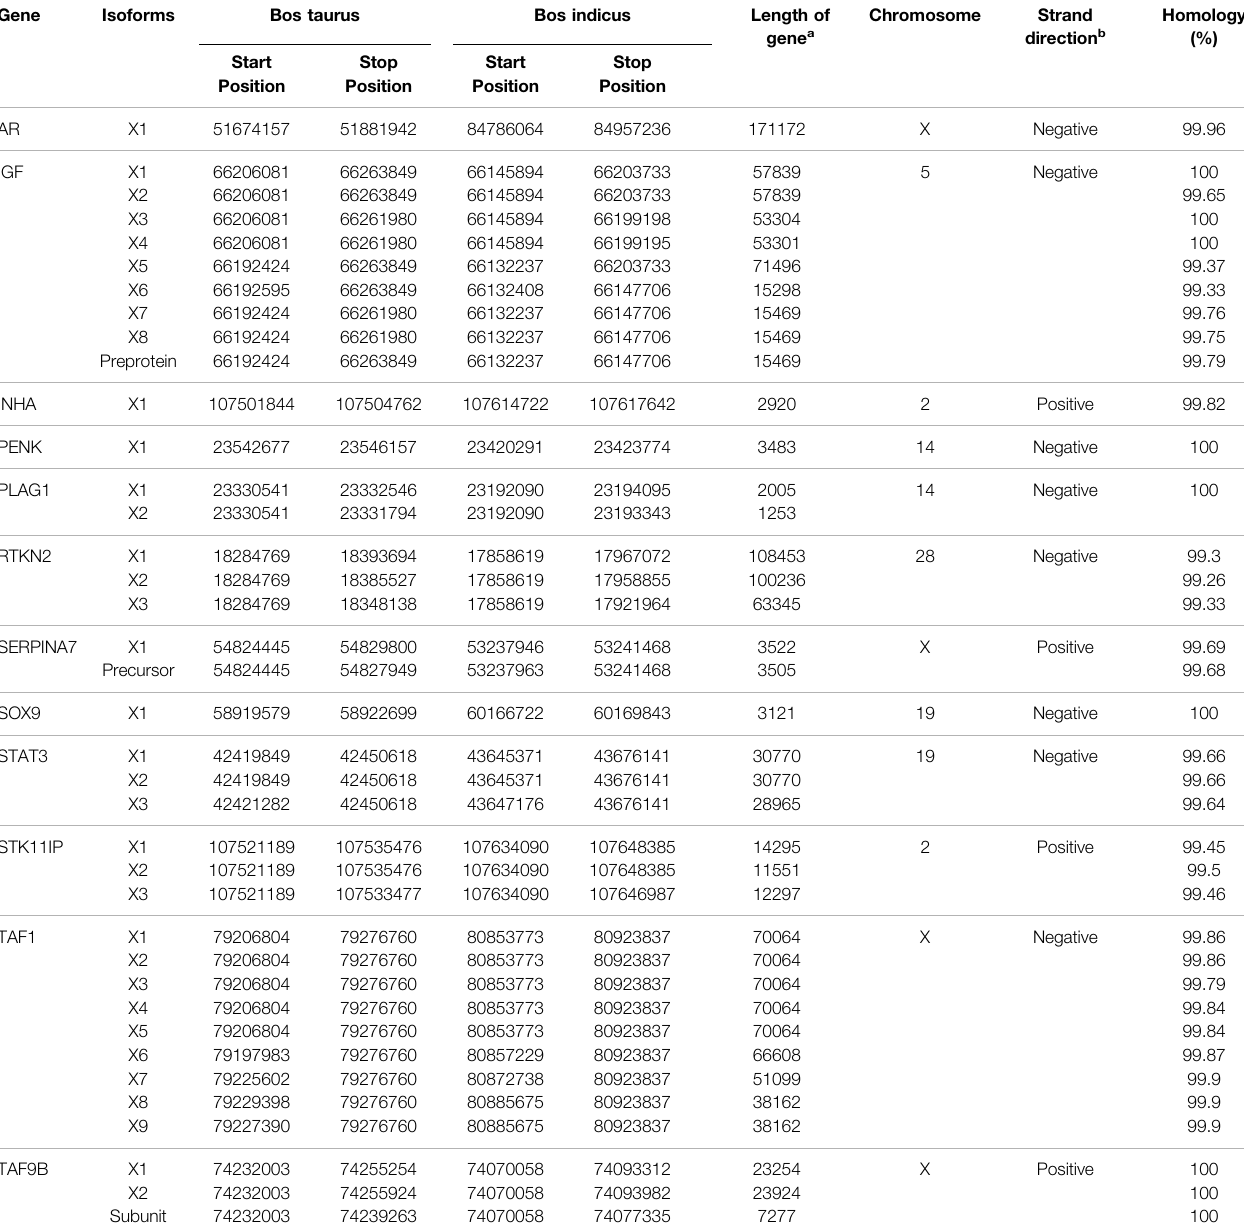
TABLE 2 | List of genes with their respective positions within Bos taurus genome and Brahman genome with their alignment length and identity. Gene Isoforms Bos taurus